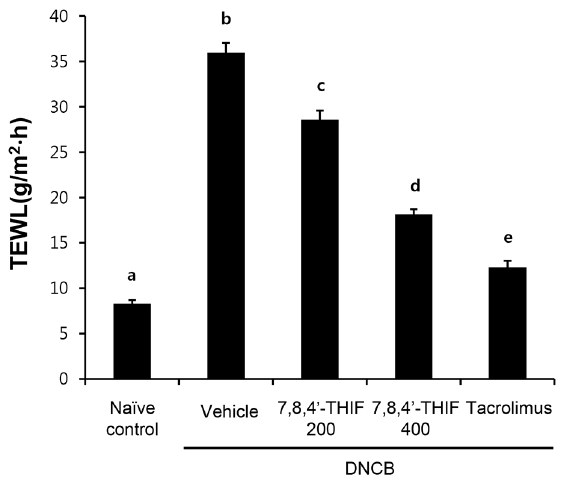
Figure 5. Effect of 7,8,4 9 -THIF on DNCB-induced increase in serum IgE level in NC/Nga mice. Blood was collected on the last day of the experiment (day 21). The level of serum IgE was measured with ELISA. Data are the means 6 SEM (n=6). Means with letters (a–c) within a graph are significantly different from each other at p , 0.05.